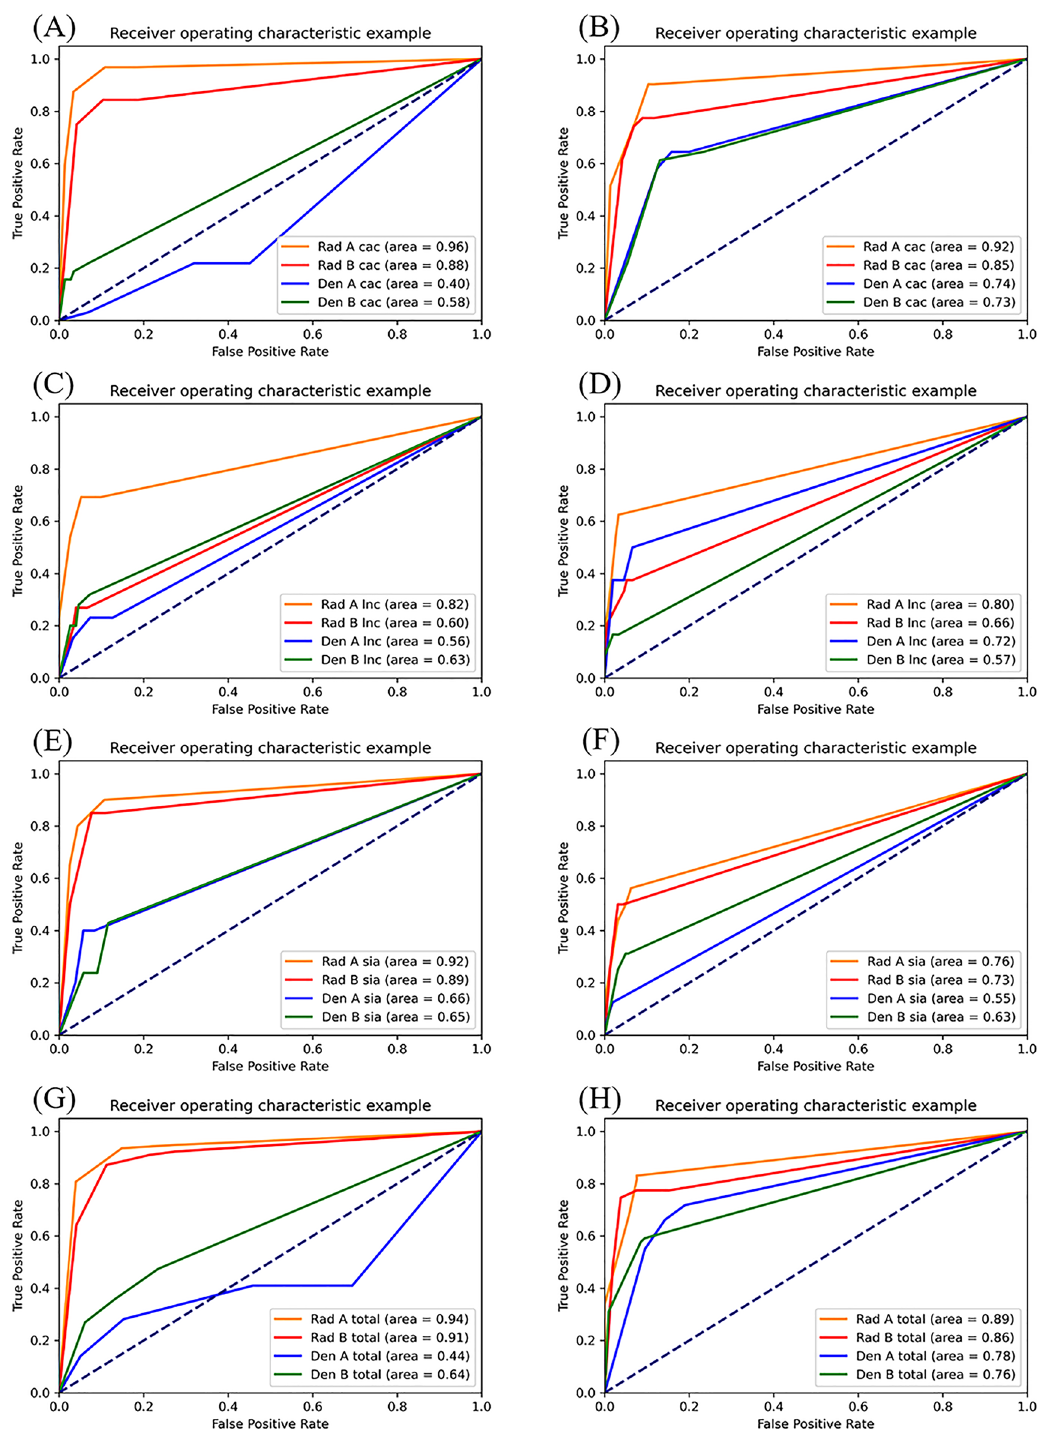
Figure 4. Comparison of carotid artery calcification, lymph node calcification, and sialolith. The comparison of first ( A ) and second ( B ) readings of carotid calcification. The comparison of first ( C ) and second ( D ) readings of lymph node calcification. The comparison of first ( E ) and second ( F ) readings of sialolith. Overall comparison of the first ( G ) and second ( H ) readings of soft tissue